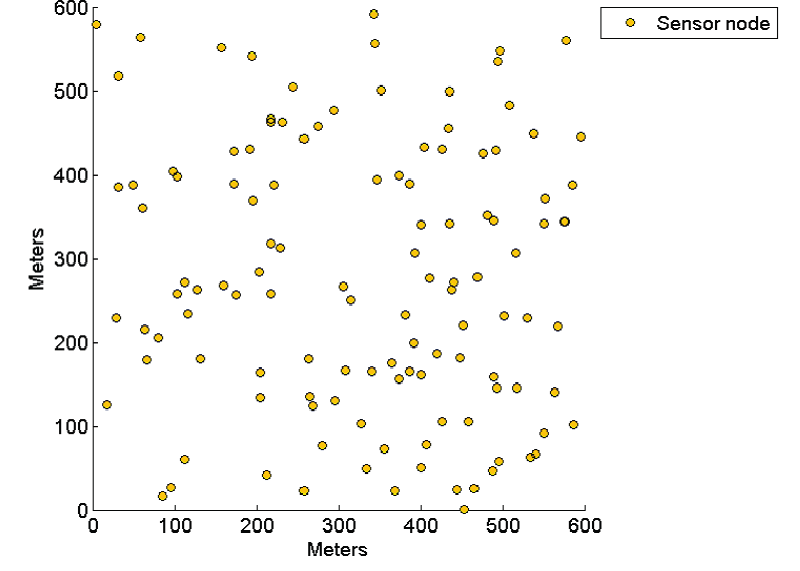
Figure 8. CRSN topology under evaluation. The circles represent the physical location of the sensor nodes in 2D.